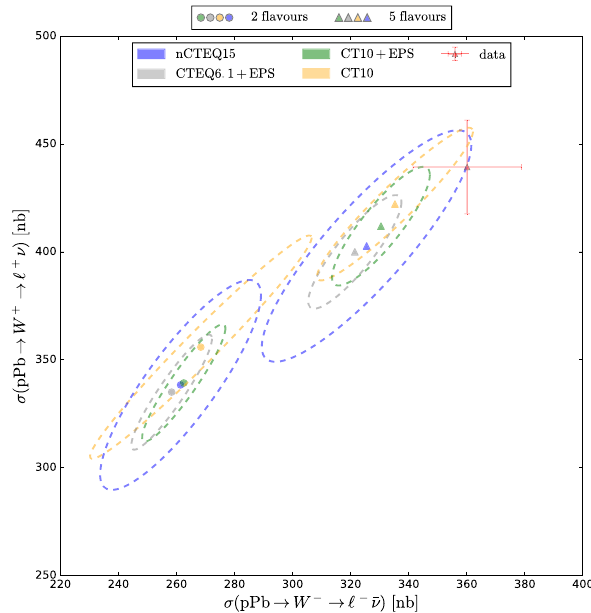
Fig. 13 Comparison of correlations between W + and W − cross sec- tions for the case when only one family of quarks { u , d } is included and when all families are accounted for. We show here results for nCTEQ15 , EPS09+CT10, EPS09+CTEQ6.1 and CT10 PDFs overlaid with the CMS